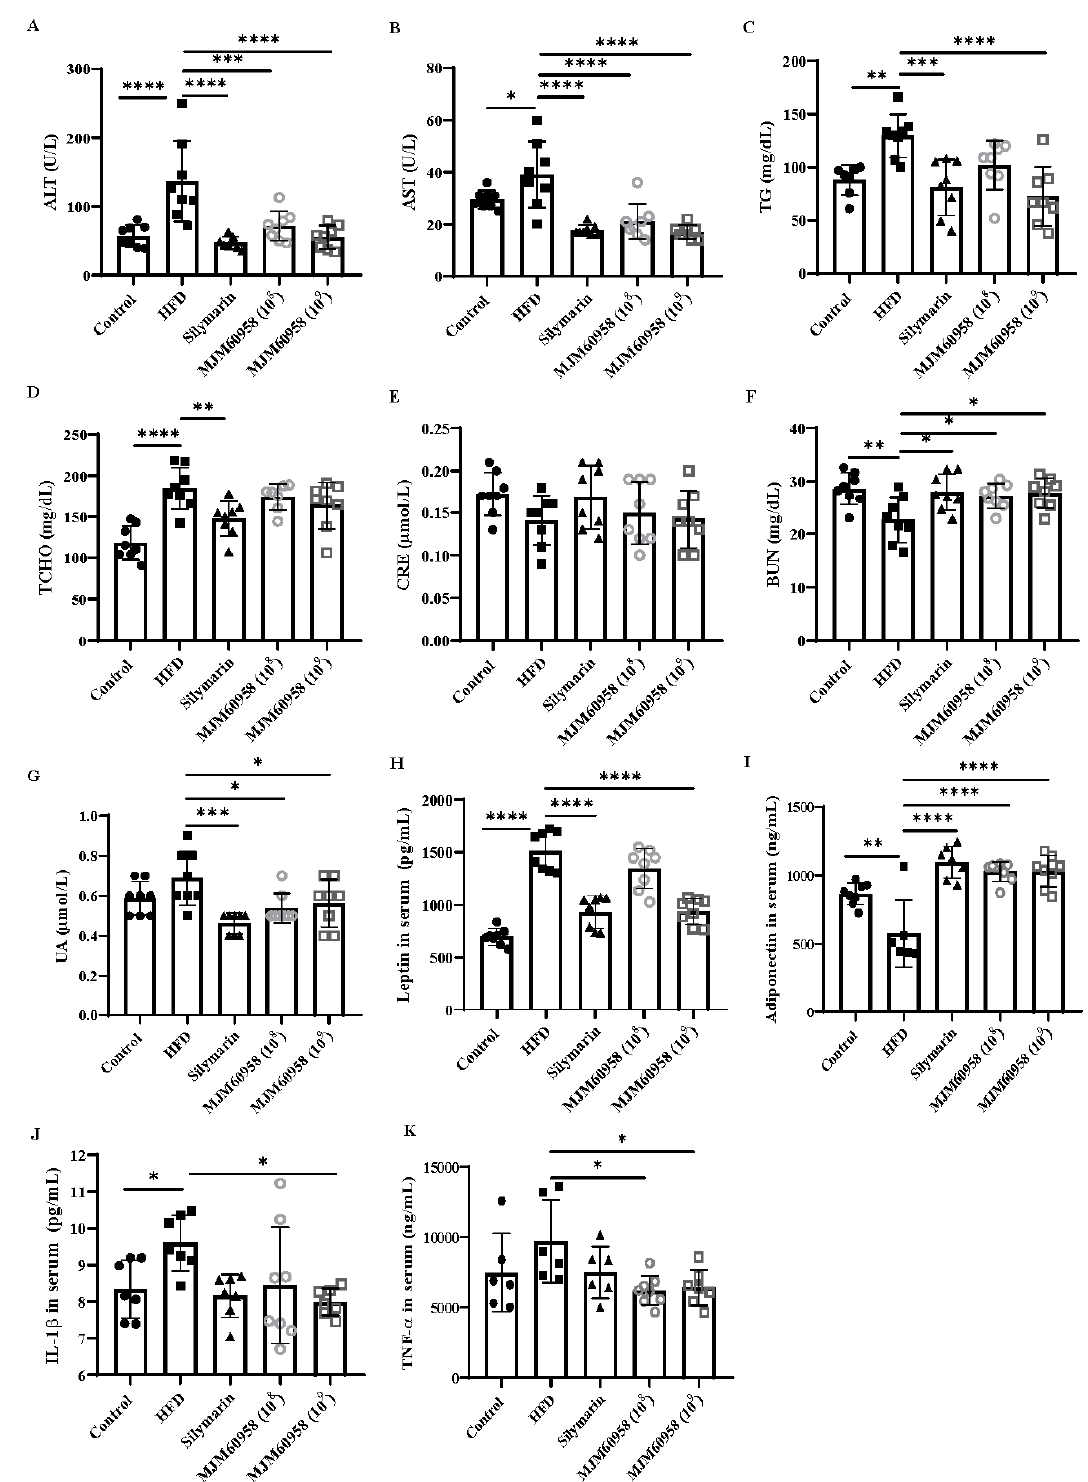
Figure 4. Effects of MJM60958 or Silymarin on the serum levels of ( A ) ALT, ( B ) AST, ( C ) TG, ( D ) TCHO, ( E ) CRE, ( F ) BUN, ( G ) UA, ( H ) leptin, ( I ) adiponectin, ( J ) IL-1 β and ( K ) TNF- α in mice fed HFD for 12 weeks. Values are the means ± SD ( n = 6 to 8 per group). * p < 0.05, ** p < 0.01, *** p < 0.001, **** p < 0.0001, compared with HFD